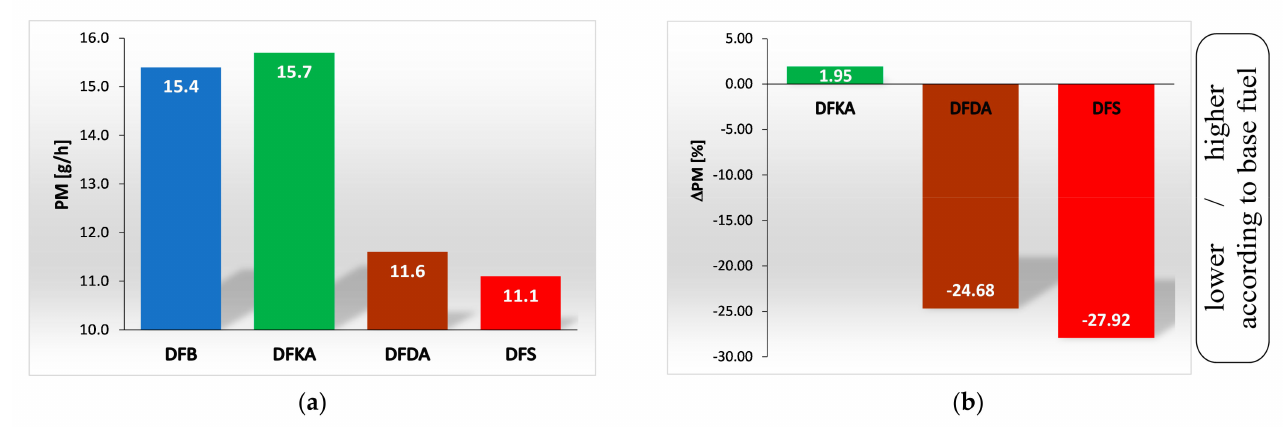
Figure 12. ( a ) PM emissions with engine exhaust for tested fuels. ( b ) Percent change in PM emissions ( ∆ PM) for tested fuels relative to DFB (base fuel).